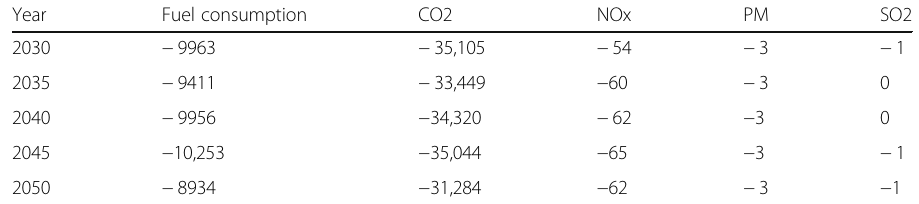
Table 6 Case study – Impact on emissions and fuel consumption p.a. (in tons), EU28 + 2, difference Scenario-Baseline